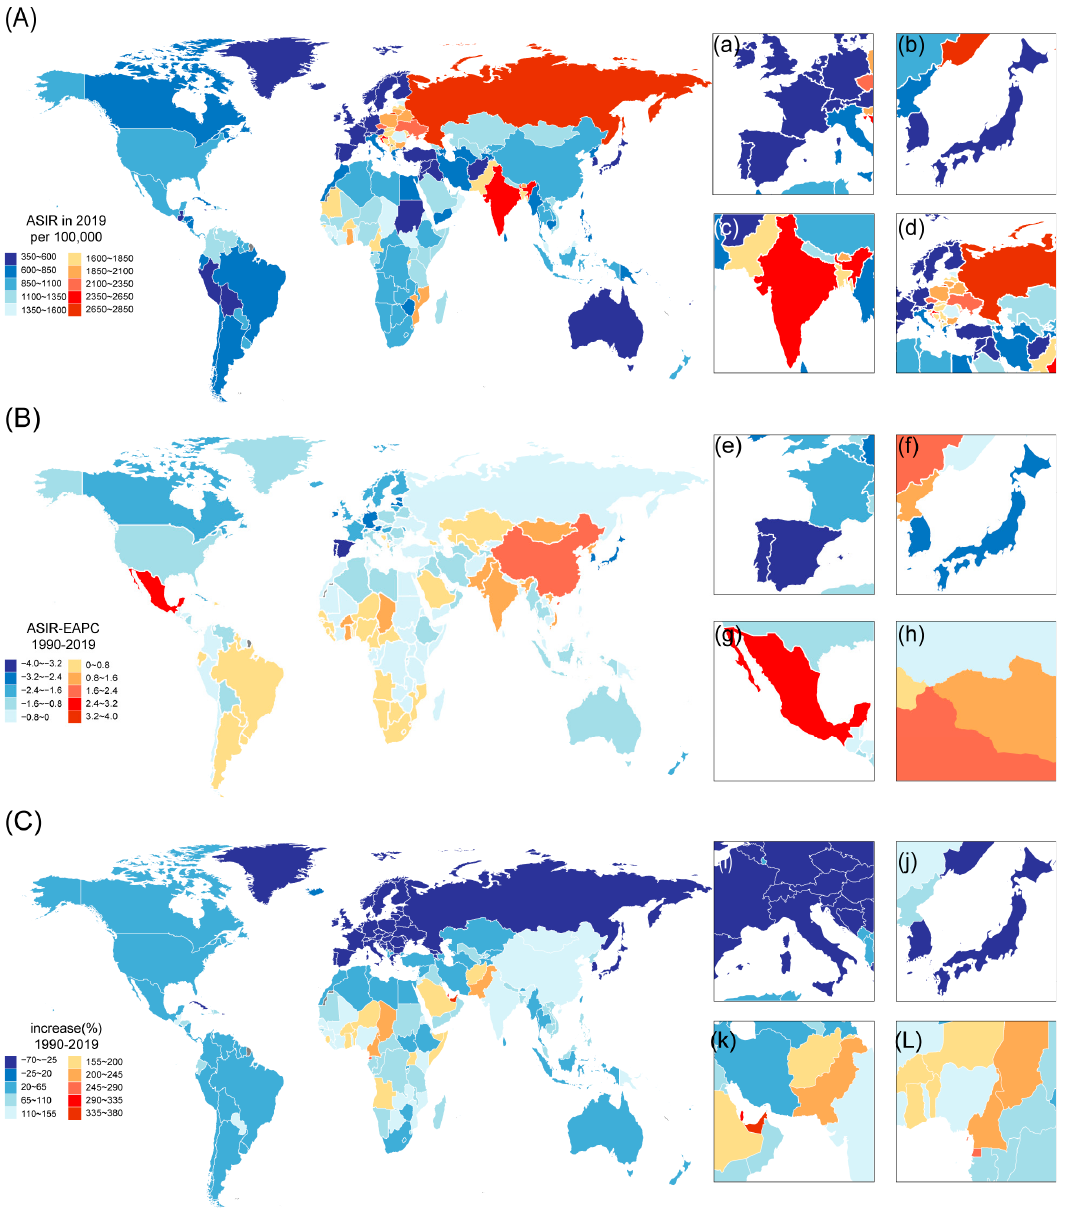
Figure 2. Incidence and its tendency from 1990 to 2019 among 204 countries and territories. ( A ) Age- standardized incidence rate (ASIR) in 2019. ( B ) EAPC of ASIR. ( C ) The absolute number for rate of incidence increase (%). Western Europe ( a ) and the high-income Asia Pacific region ( b ) with lower ASIR; South Asia ( c ) and Eastern Europe ( d ) with a higher ASIR. Western Europe ( e ) and the high- income Asia Pacific region ( f ) with lower ASIR-EAPC; central Latin America ( g ) and East Asia ( h ) with higher ASIR-EAPC. Most of Western Europe ( i ) and some of the high-income Asia Pacific re- gion ( j ) with a lower increase in incidence; North Africa and the Middle East ( k ) and central sub- Saharan Africa ( l ) with a higher increase in incidence.